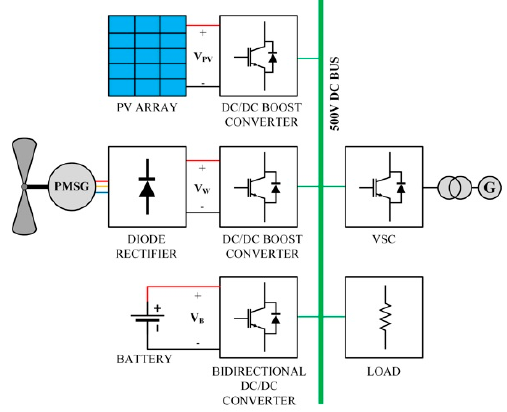
Figure 1. Overall structure of the DC microgrid.